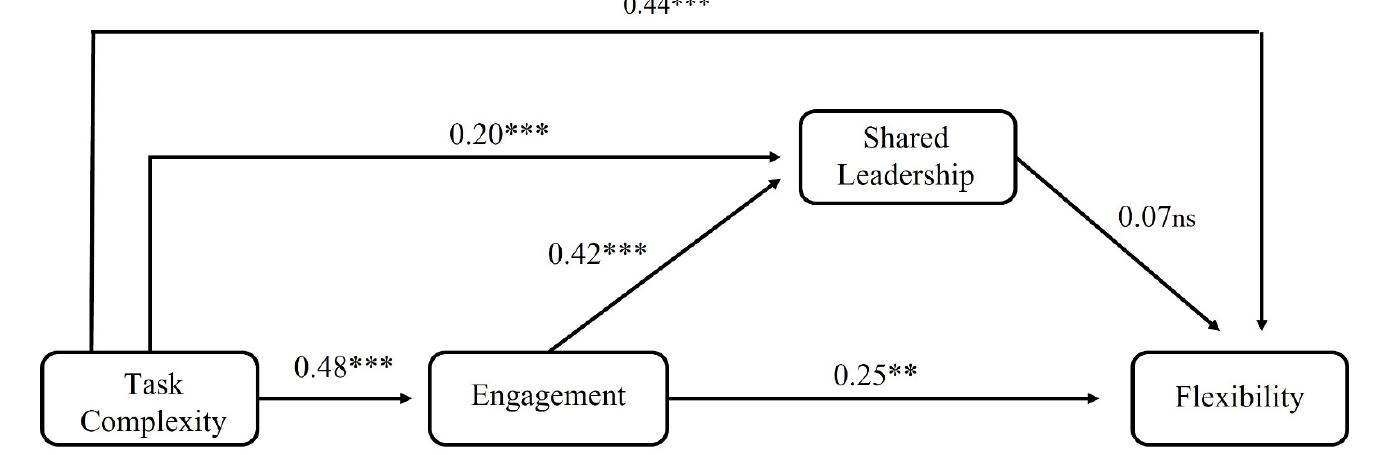
Figure 3. Model 2. Notes: ns = no significant; ** p < 0.01; *** p < 0.001 . Table 8. Indirect effects of model 2 .